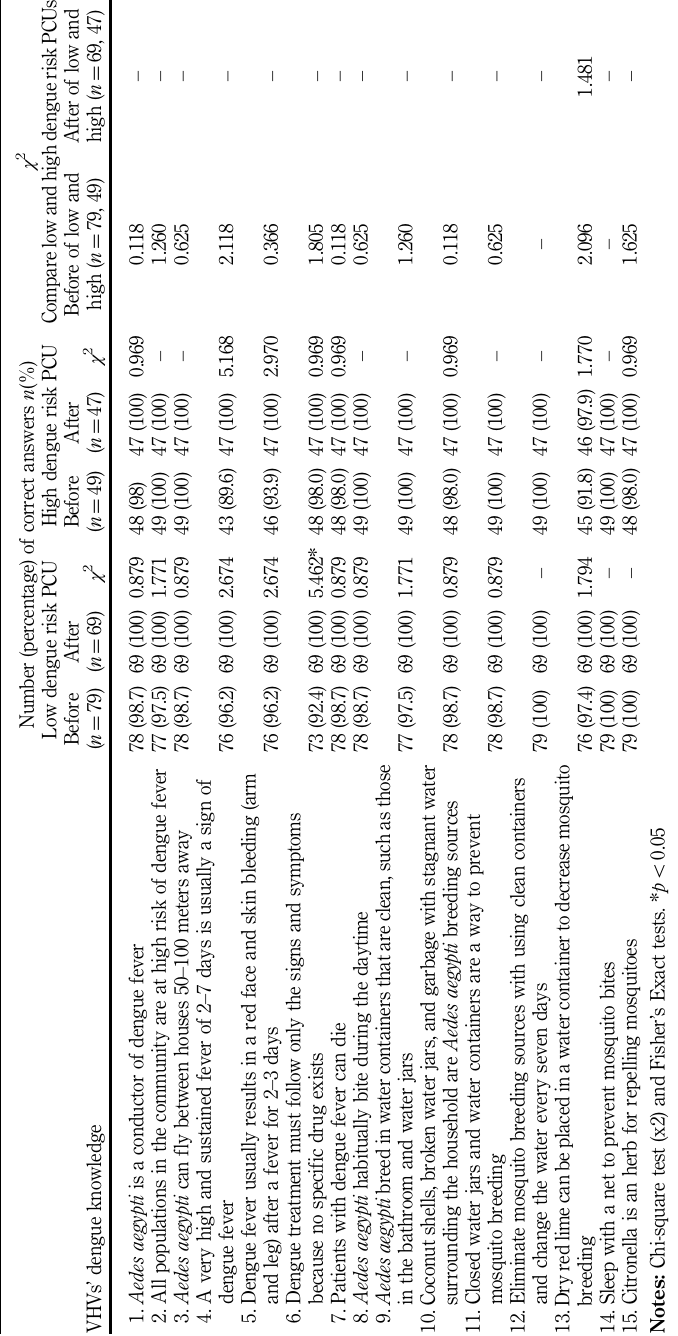
knowledge before and after developing the surveillance